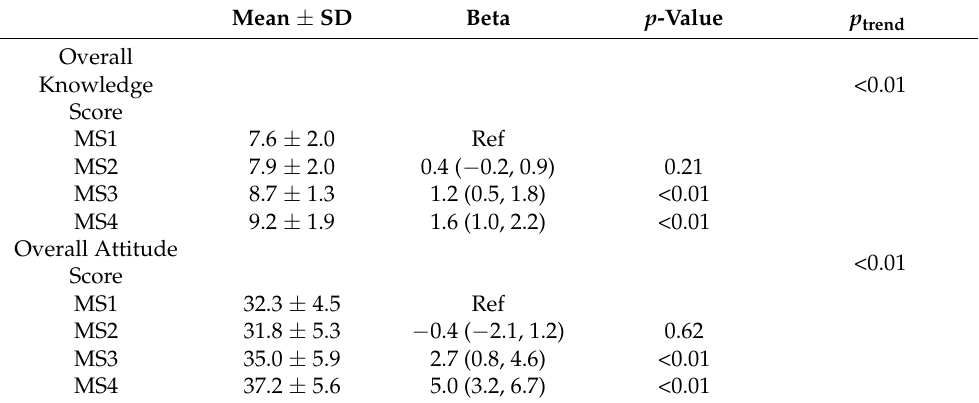
Table 3. Associations between knowledge score, attitude score and standing year in Medical